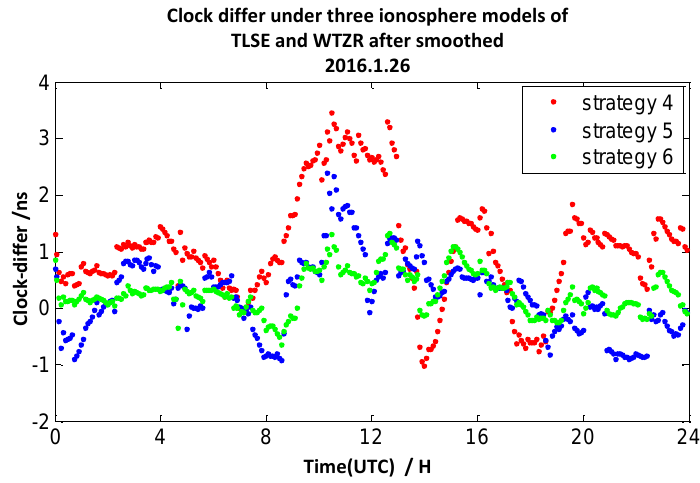
Figure 19. The clock di ff erence under three ionosphere models of TLSE and WTZR after being smoothed.